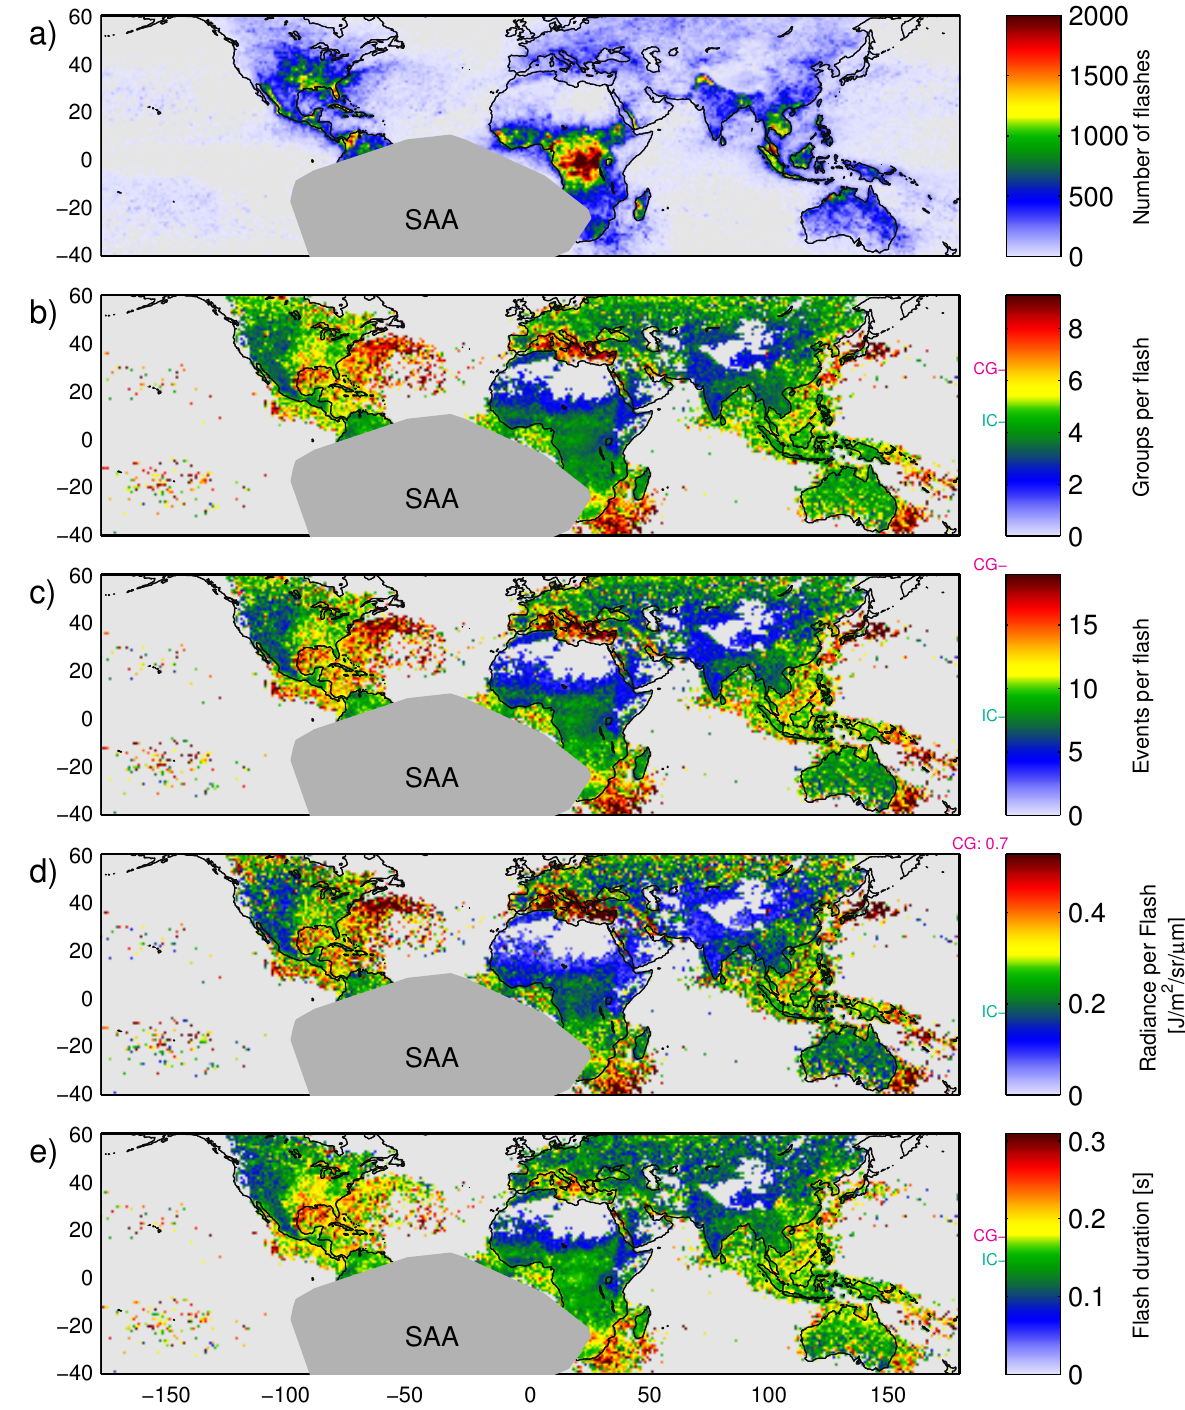
Figure 1. (a) Total number of flashes derived from OTD (1995–2000) on 1 ◦ × 1 ◦ grid. Parts of South America are masked out by the applied quality flags as a consequence of the SAA. (b–e) Mean flash properties, i.e. groups (b) , events (c) , radiance (d) , and duration (e) per flash. Grid pixels with less than 50 flashes and the area affected by the SAA are discarded (light/dark grey, respectively). The color scale of panels (b) to (e) ranges from 0 to twice the respective global mean value (see first row in Table 2). The IC/CG marks in cyan/magenta at the colorbar indicate the mean properties of IC/CG flashes in the US as derived by Koshak (2010) (see Sect. 4.4 for details). The corresponding data shown in this figure is provided as hdf files in the